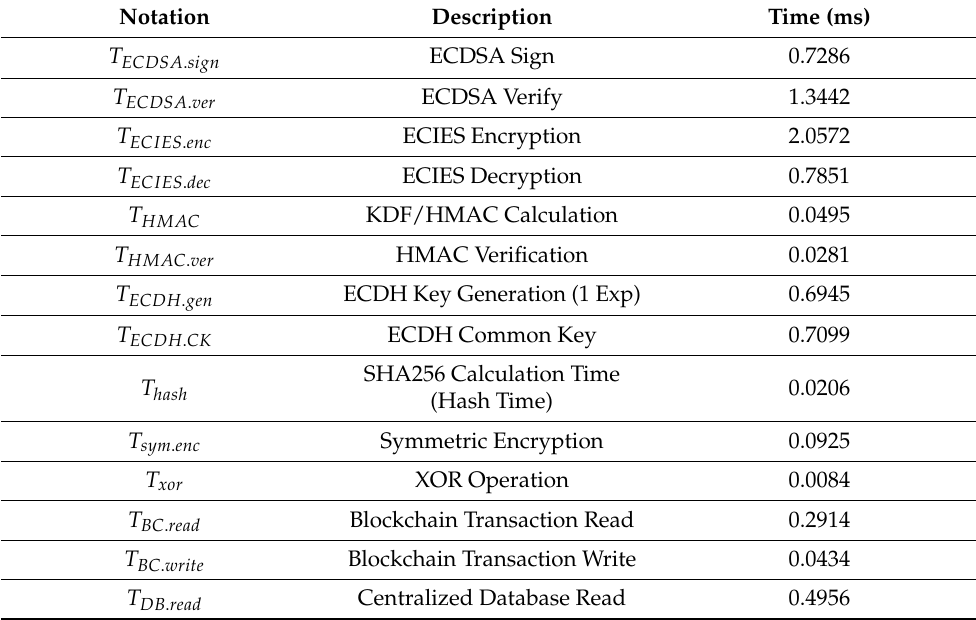
Table 4. Experimental time for different functions.